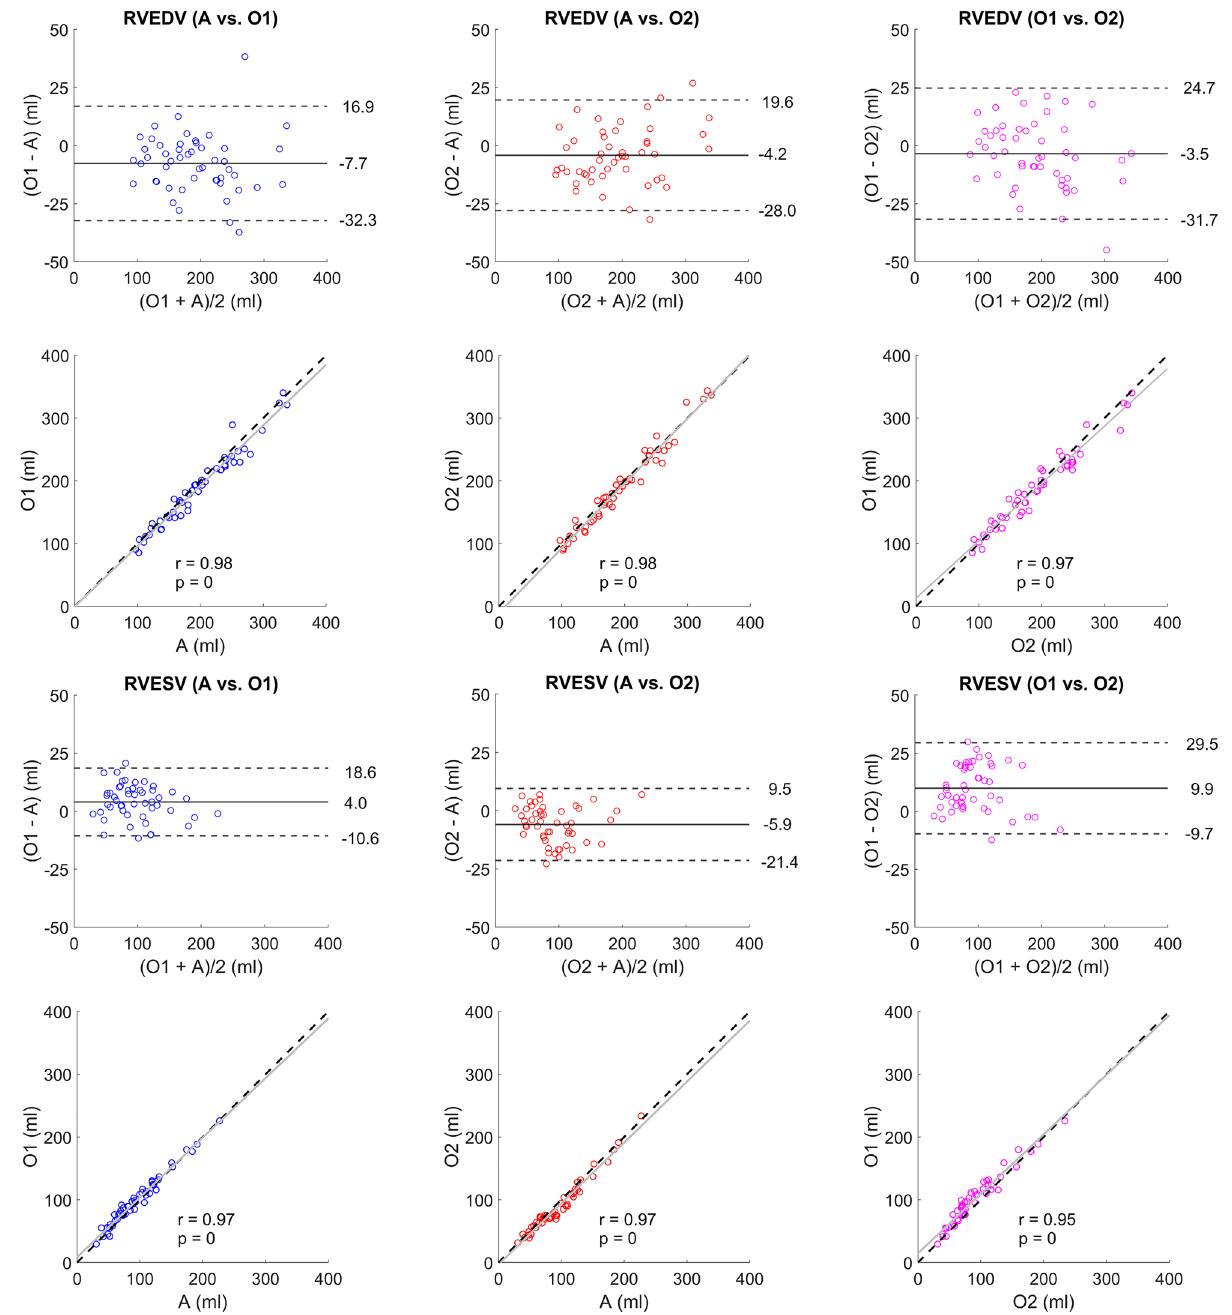
Figure 4. Bland–Altman plots and scatter plots on the clinical validation set. The left column (blue) shows the pipeline’s automated (A) delineations vs. Observer 1 (O1), the middle column (red) shows A vs. Observer 2 (O2), and the right column (magenta) shows O1 vs. O2. The top half shows right ventricular (RV) end- diastolic volumes (RVEDV) and the bottom row RV end-systolic volumes (RVESV). The Bland–Altman plots contain bias (full lines) and limits of agreement (± 1.96 SD, dashed lines). The correlation plots contain identity lines (black, dashed lines), least squares lines (grey, full lines), Spearman’s rank correlation coefficients (r) and corresponding p on the CVS. The average time reduction (compared to delineating manually) by using pipeline delineations and correcting insufficient ones, was 5 min and 17 s (87% of the average manual delineation time).